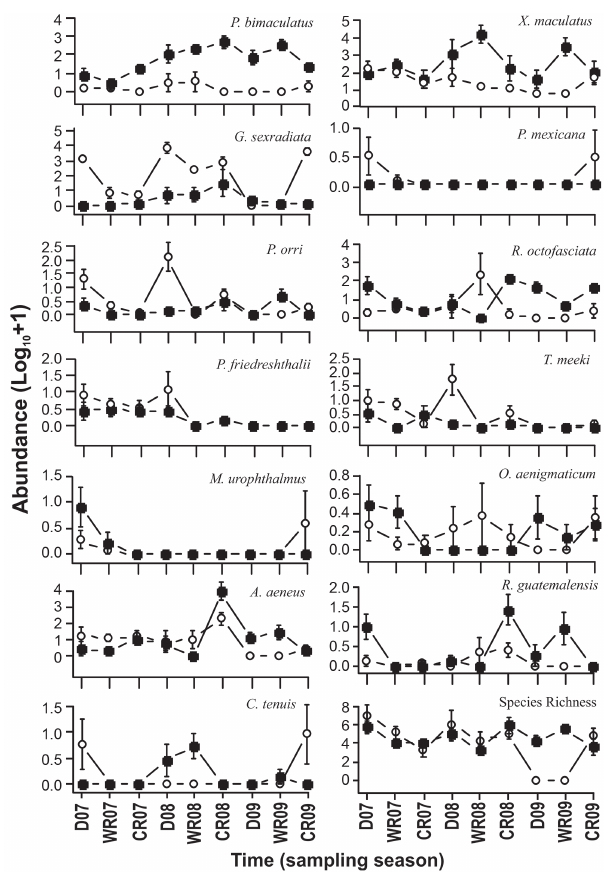
Fig. 3. Fish population patterns in permanent (PP) and temporary pools (TP) over time. The three sampling periods within years describe general seasonal patterns. Error bars represent + 1 S.E. X-axis represents sampling seasons (D = Dry, WR = Warm rainy, and CR = Cold rain) and years (07 = 2007, 08= 2008, and 09 = 2009).